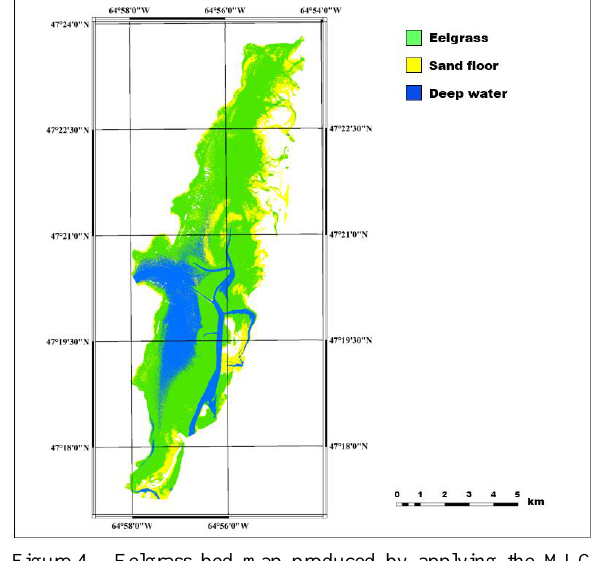
Figure 4. Eelgrass bed map produced by applying the MLC classifier to the eight bands of the WorldView-2 image.